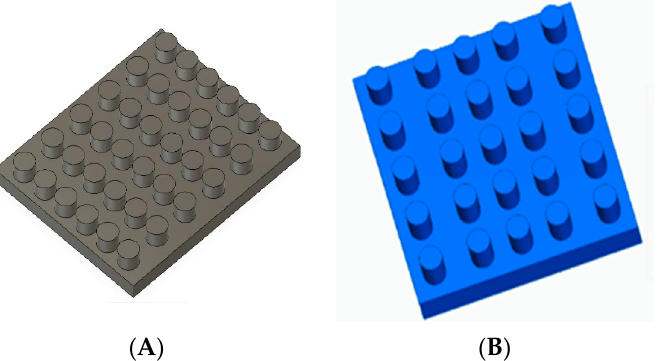
Figure 2. 3D designs for scaffolding. ( A ) molds for scaffolds implemented in cell culture and ( B ) molds for test tubes to evaluate mechanical properties.